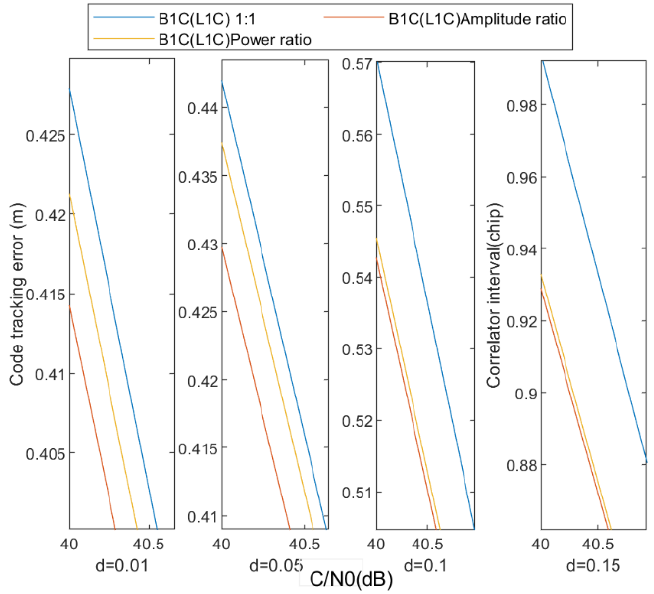
Figure 7. The DLL std of the three combination schemes, Bf = 32 MHz.